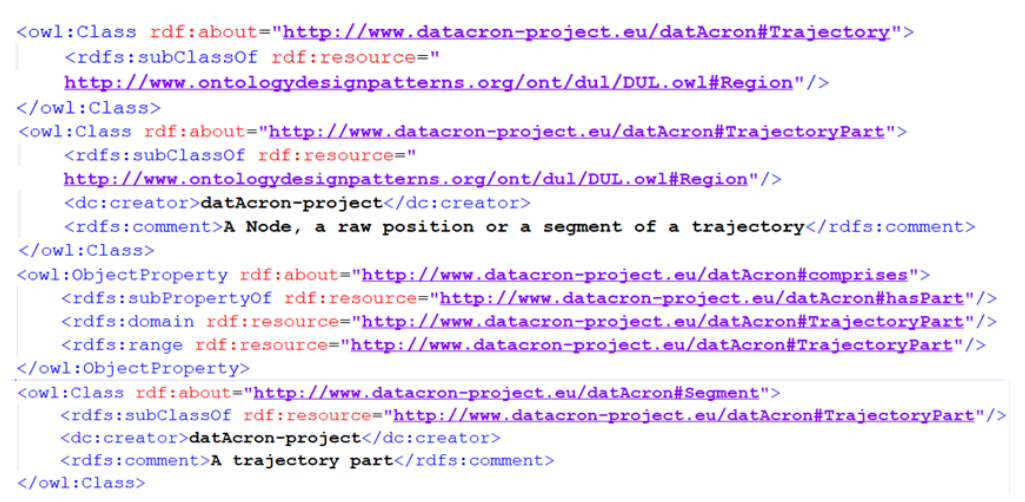
Figure 7. Semantic trajectory definition according to datAcron ontology.